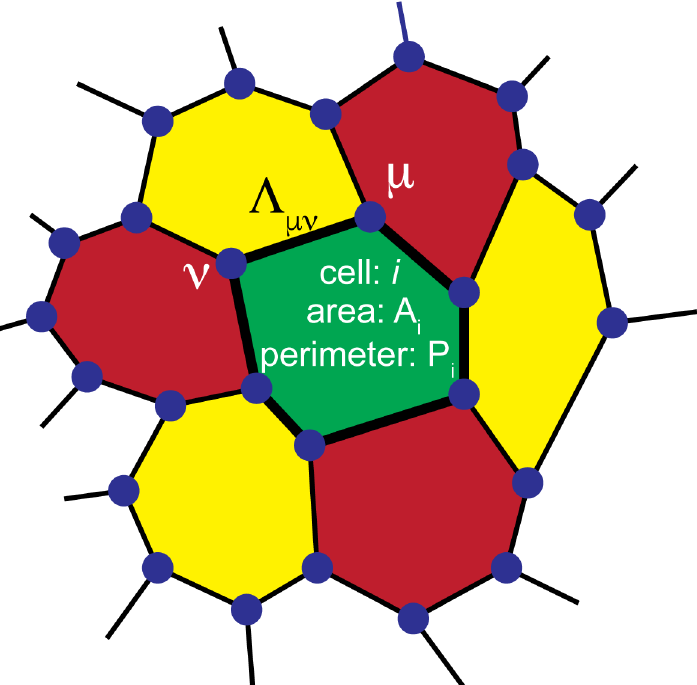
Fig 1. In the Vertex Model (VM), a confluent epithelial sheet is represented as a polygonal tiling of the plane with no holes or overlaps. Each cell is representedby an n − sidedpolygon. Neighbouringcells share an edge, which models the cell junction as a straight line. Three edgesmeet at a vertex (dark blue dots). The behaviour of cell i is describedby three parameters: 1) reference area A 0 , 2) area modulus K i , and 3) i perimeter modulus Γ i . In addition, a junction connectingvertices μ and ν has tension Λ μν